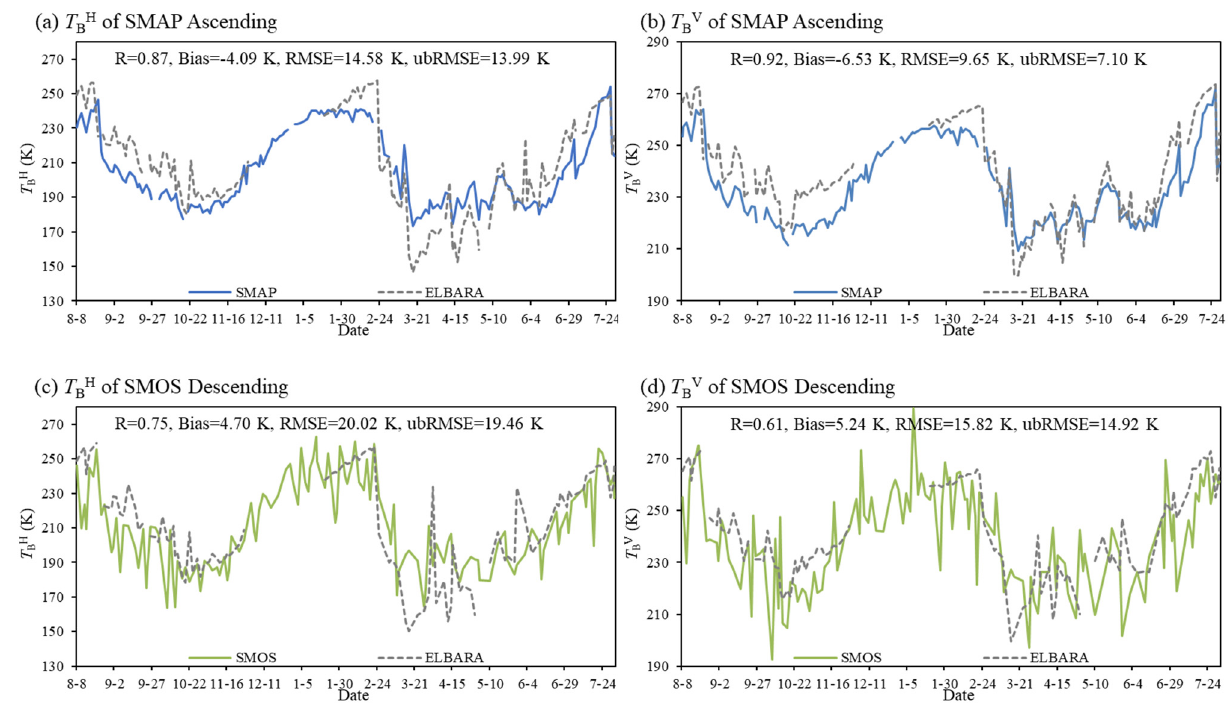
Figure 1. Time series of SMAP and ELBARA-III measured ( a ) T BH and ( b ) T BV , and SMOS and ELBARA-III measured ( c ) T BH and ( d ) T BV during the evening overpasses between August 2016 and July 2017. ( a , b ) are modified from Zheng et al. [39].